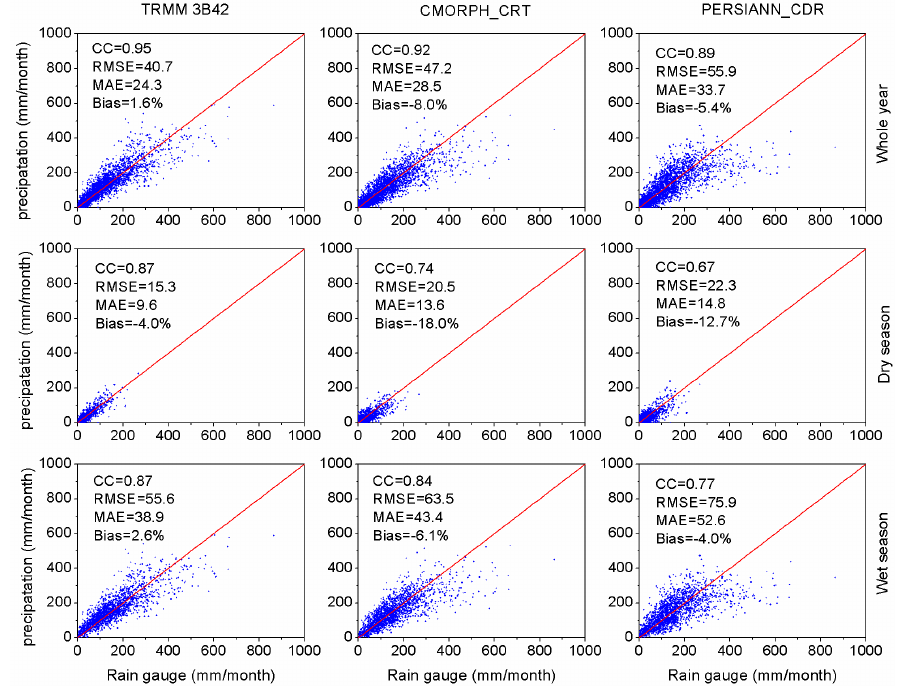
Figure 3. Scatterplots of monthly precipitation from TRMM 3B42, CMORPH_CRT, and PERSIANN_CDR against ground observations at the grid scale: the three panels show the results from the whole year (upper panel), dry season (mid panel), and wet season (lower panel). The red line indicates a 1:1 correspondence.